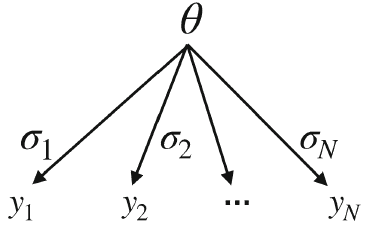
Fig. 1 Ordinary averaging. We assume that the y i are random out- comes of measurements of the same parameter θ